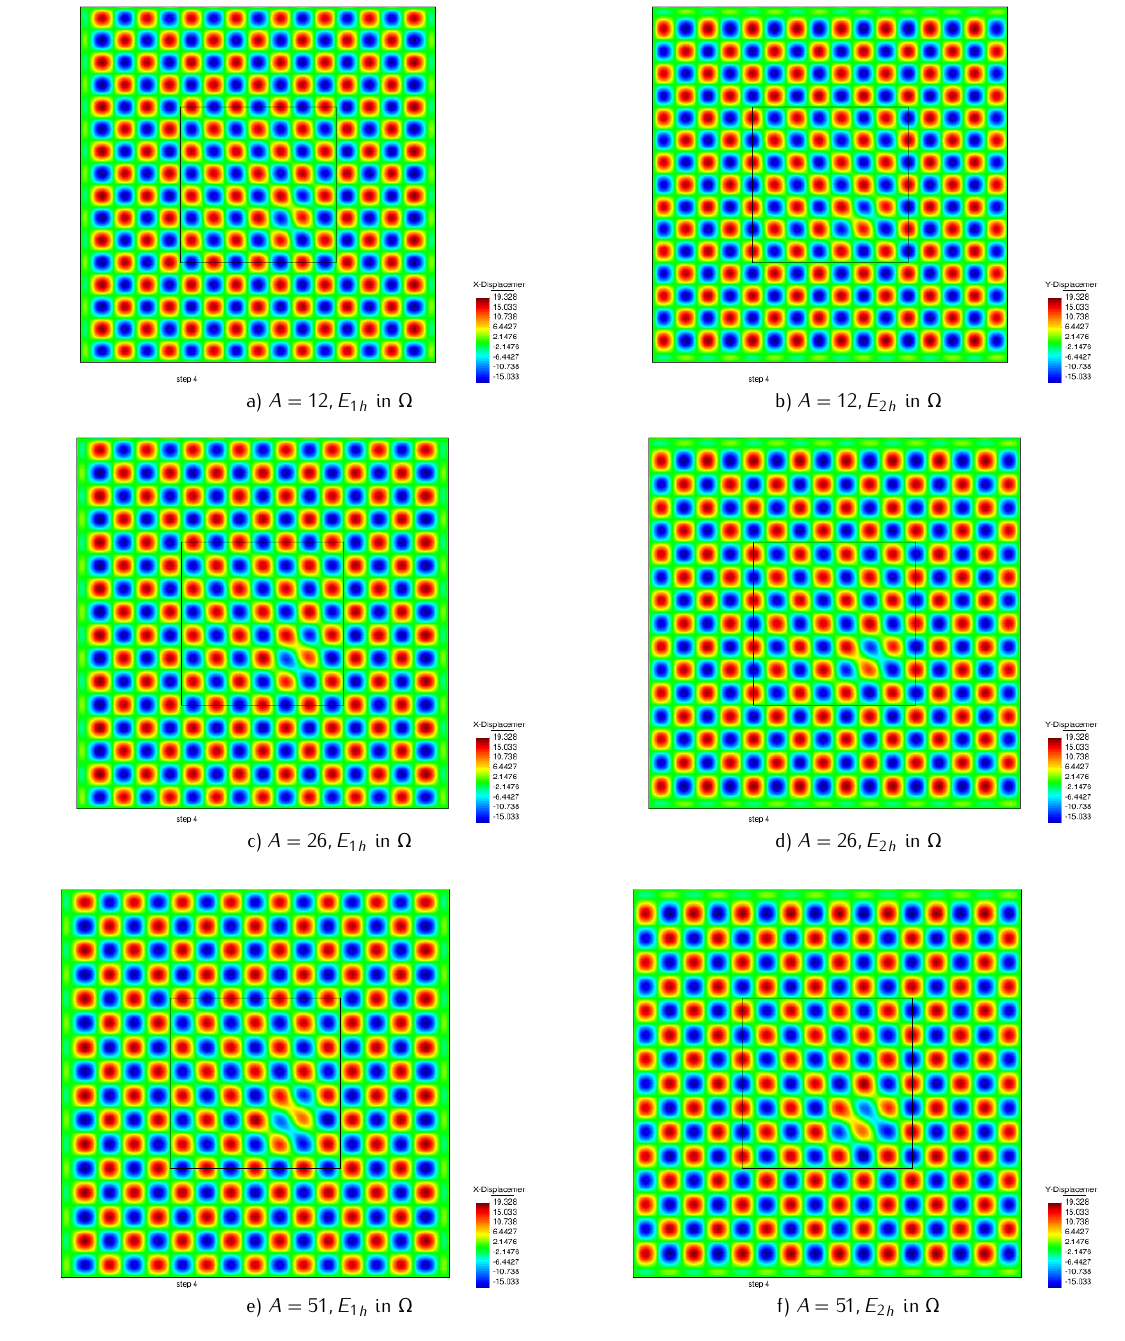
Figure 7. Test 1. Computedsolutions E h = ( E 1 h ,E 2 h ) inthe domaindecompositionFEM/FDMattime moment t = 8 . 0 in Ω . Weshow comparisons of the computed solutions versus different values of the coefficient ε ( x ) inside Ω for Maxwell’s equations: in a) and b) the amplitude A = 26 in (46) ; in c) and d) A = 51 in (46)